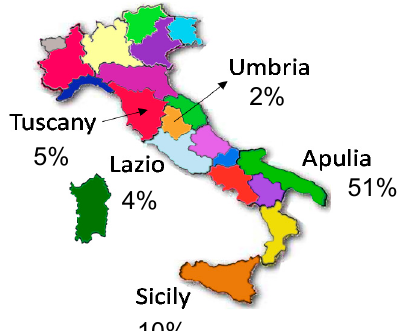
Figure 1. A map of Italy evidencing regions in which the 60 EVOO considered in the present study were collected. The 2016–2019 percentage averages of production are reported for each region (source: ISMEA, Institute of Services for Agricultural and Food Market [39]).